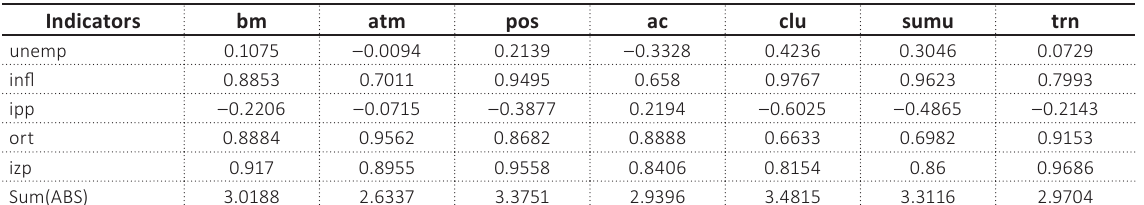
Table 1. Correlation between non-financial indicators and the BPC market indicators